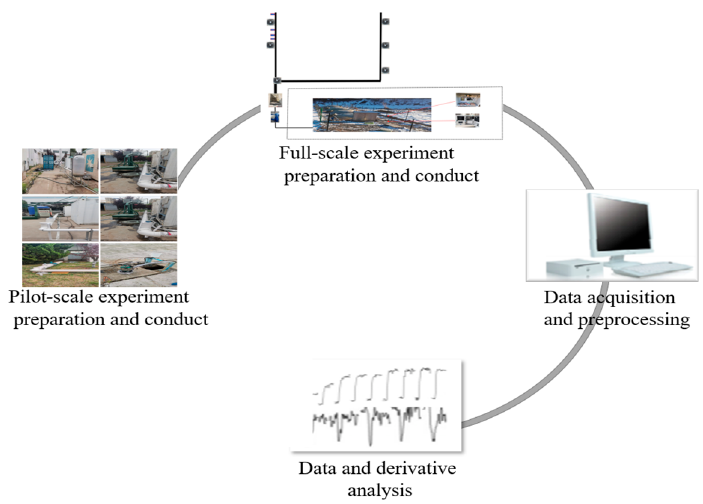
Figure 1. Experimental design for the identification and positioning of sewer blockage.